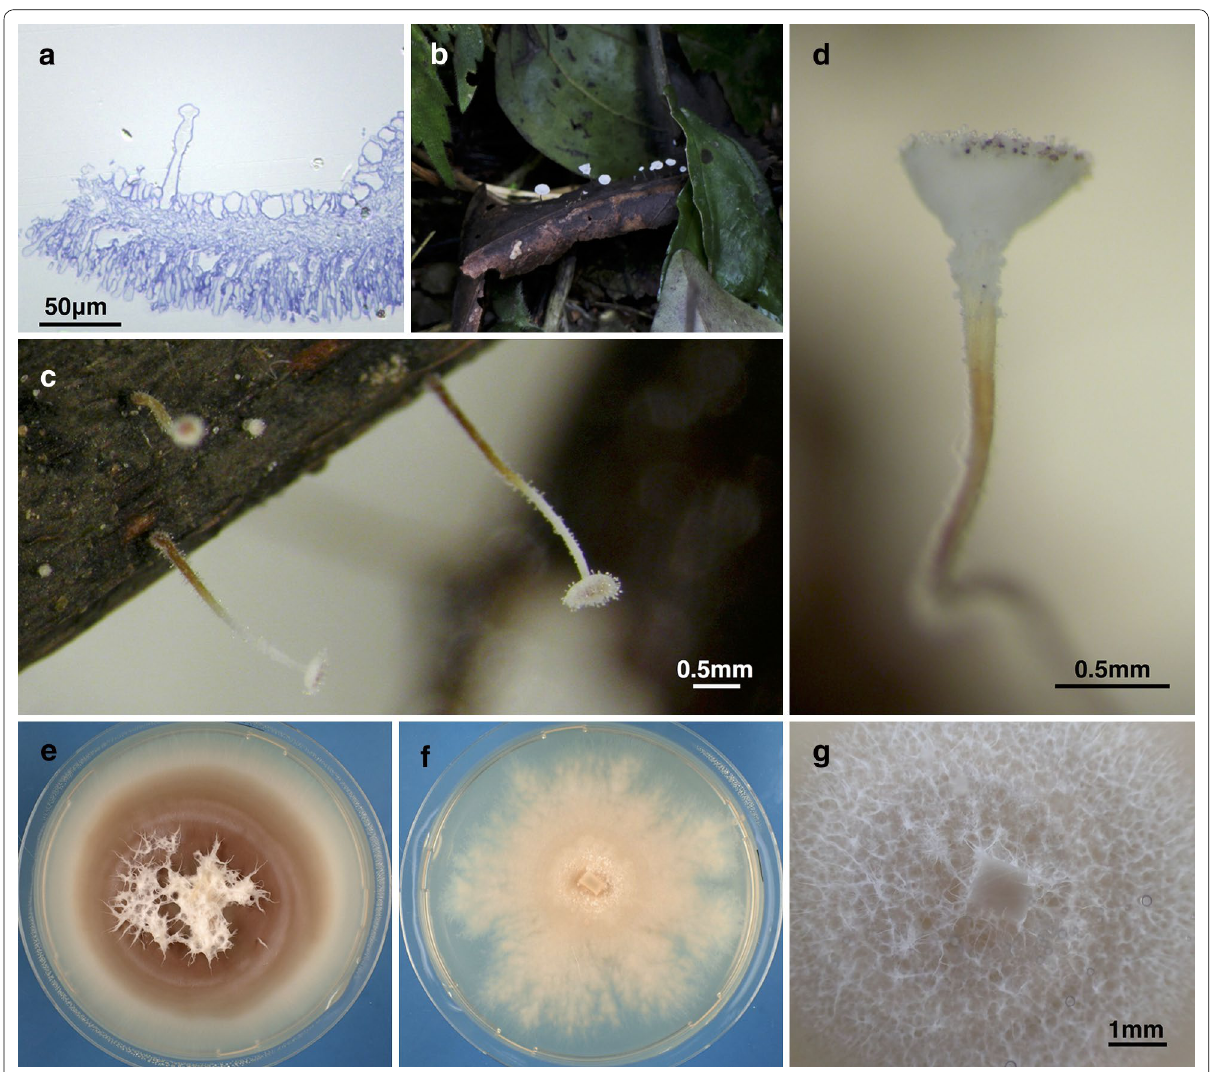
Fig. 4 Gloiocephala epiphylla. a Section of pileus showing distinct layers and pileogloeocystidum. b, c Basidiomata in natural habit. d Basidioma in detail. e Culture on PDA. f Culture on MEA. g Culture on